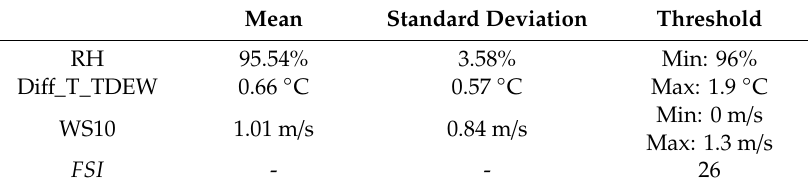
Table 8. Mean, standard deviation and thresholds selected for relative humidity, surface temperature / dew point depression and wind speed measured in fog condition and FSI threshold calculated using Youden’s index for